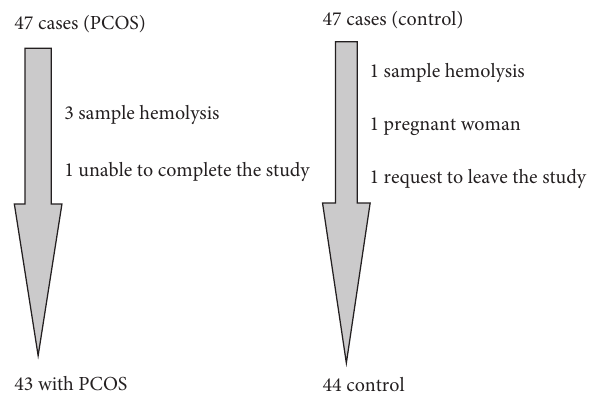
Figure 1: Flowchart of the study.